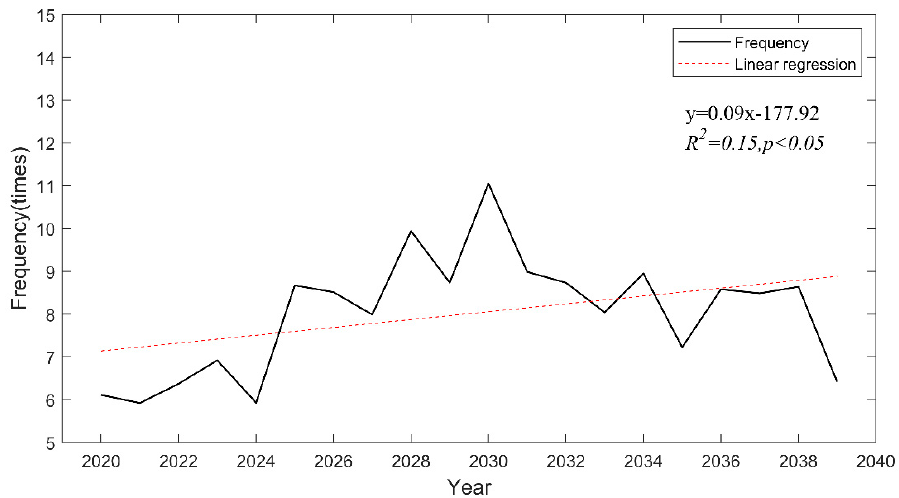
Figure 2. Annual extreme precipitation events frequencies on the Loess Plateau for the 1.5 °C global warming scenario.